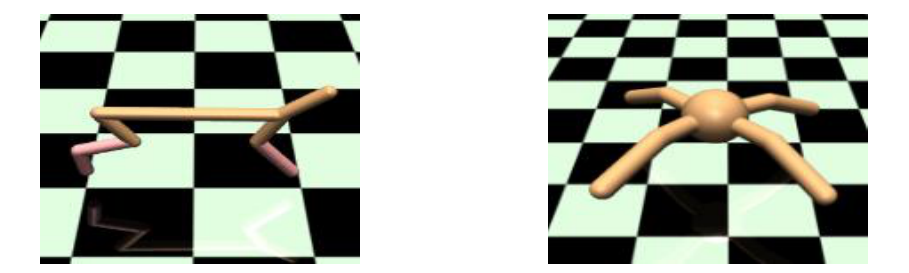
Figure 5. From left to right: HalfCheetah-v1,